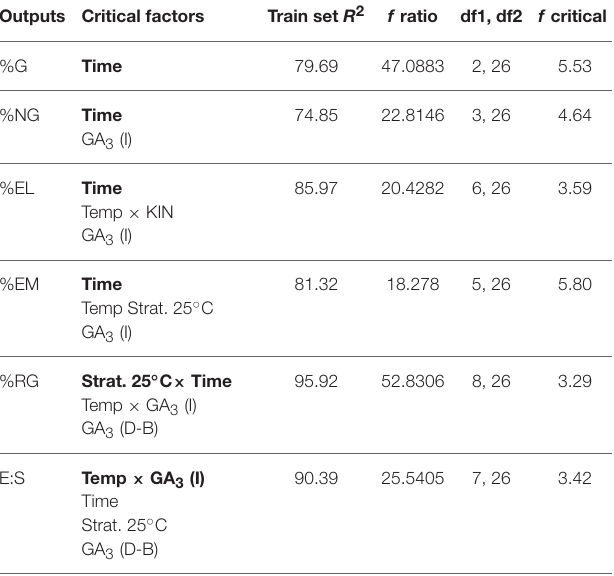
TABLE 4 | Critical factors from the neurofuzzy logic Train R 2 and ANOVA parameters for training [ f ratio, degree of freedom (df1: model and df2: total) and f critical value for α < 0.01] for each